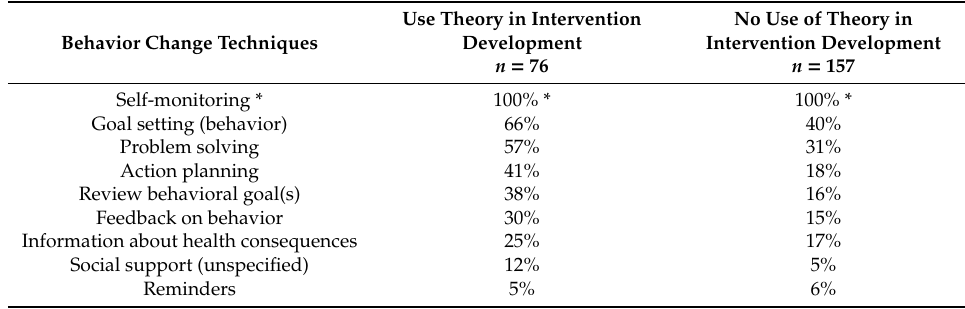
Table 6. Behavior change techniques in development of self-care interventions for patients with a chronic